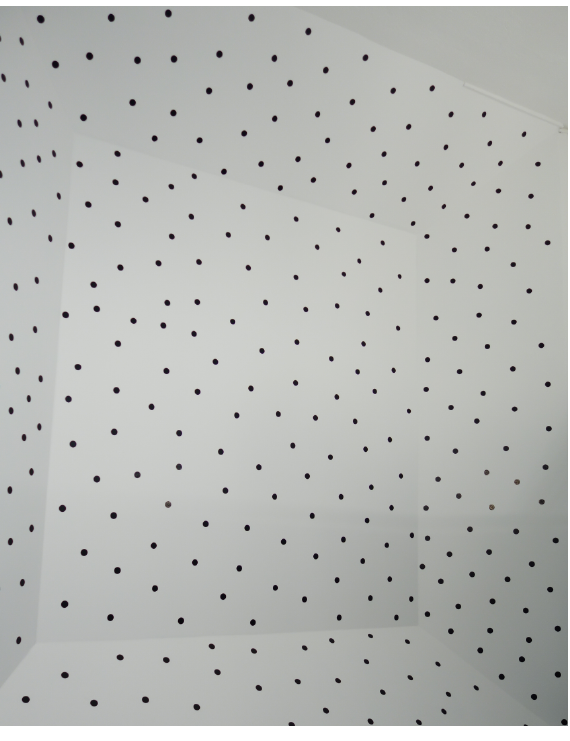
Figure 2: 3D test field imaged with surveying camera